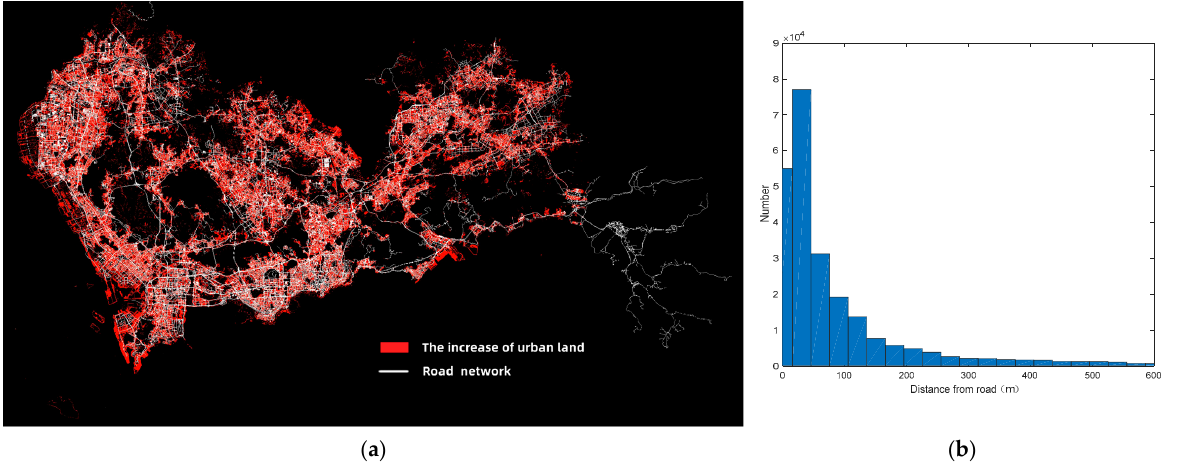
Figure 8. The relationship between transportation and urban land increase from 1979 to 2022. ( a ) The road network overlaid on the map of urban land expansion. ( b ) The transportation distance histograms for urban land increase.